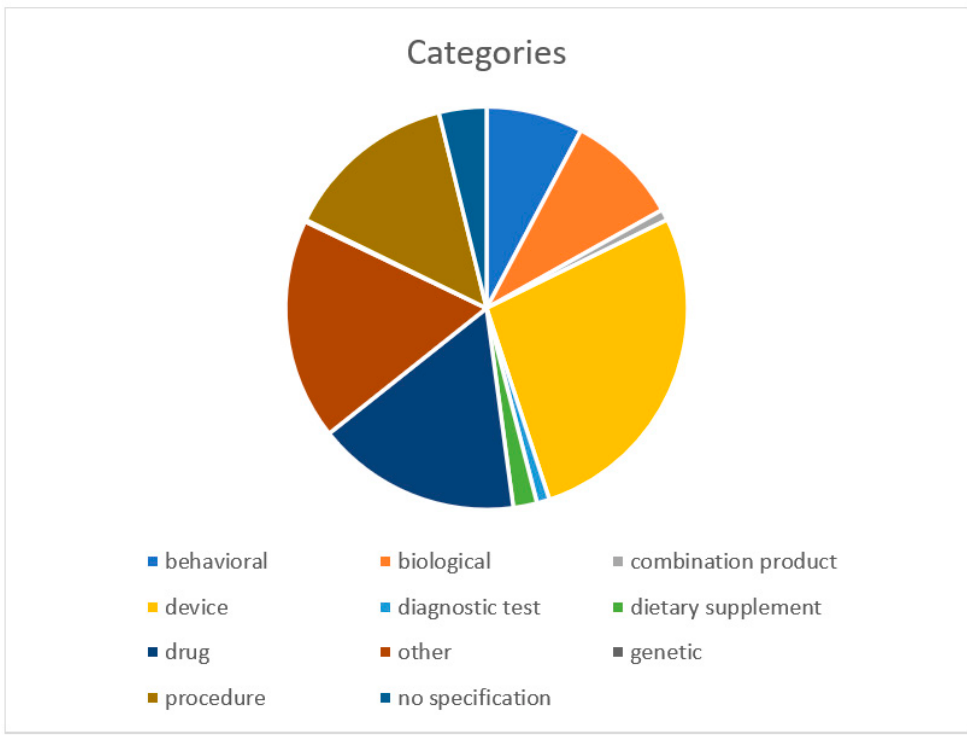
Figure 2. Interventional trials categories.